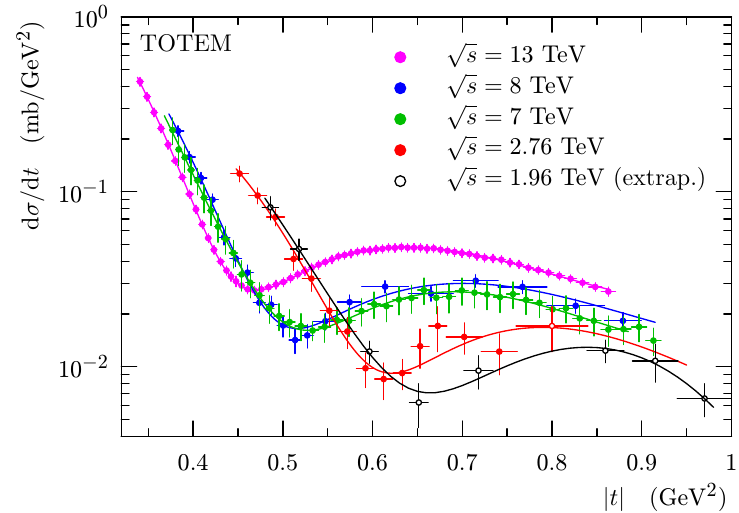
Figure 1: TOTEM measured pp elastic cross sections as a function of | t | at 2.76, 7, 8, and 13 TeV (full circles), and the extrapolation (discussed in the text) to 1.96 TeV (empty circles). (Figure reproduced from Ref. [ 2 ]